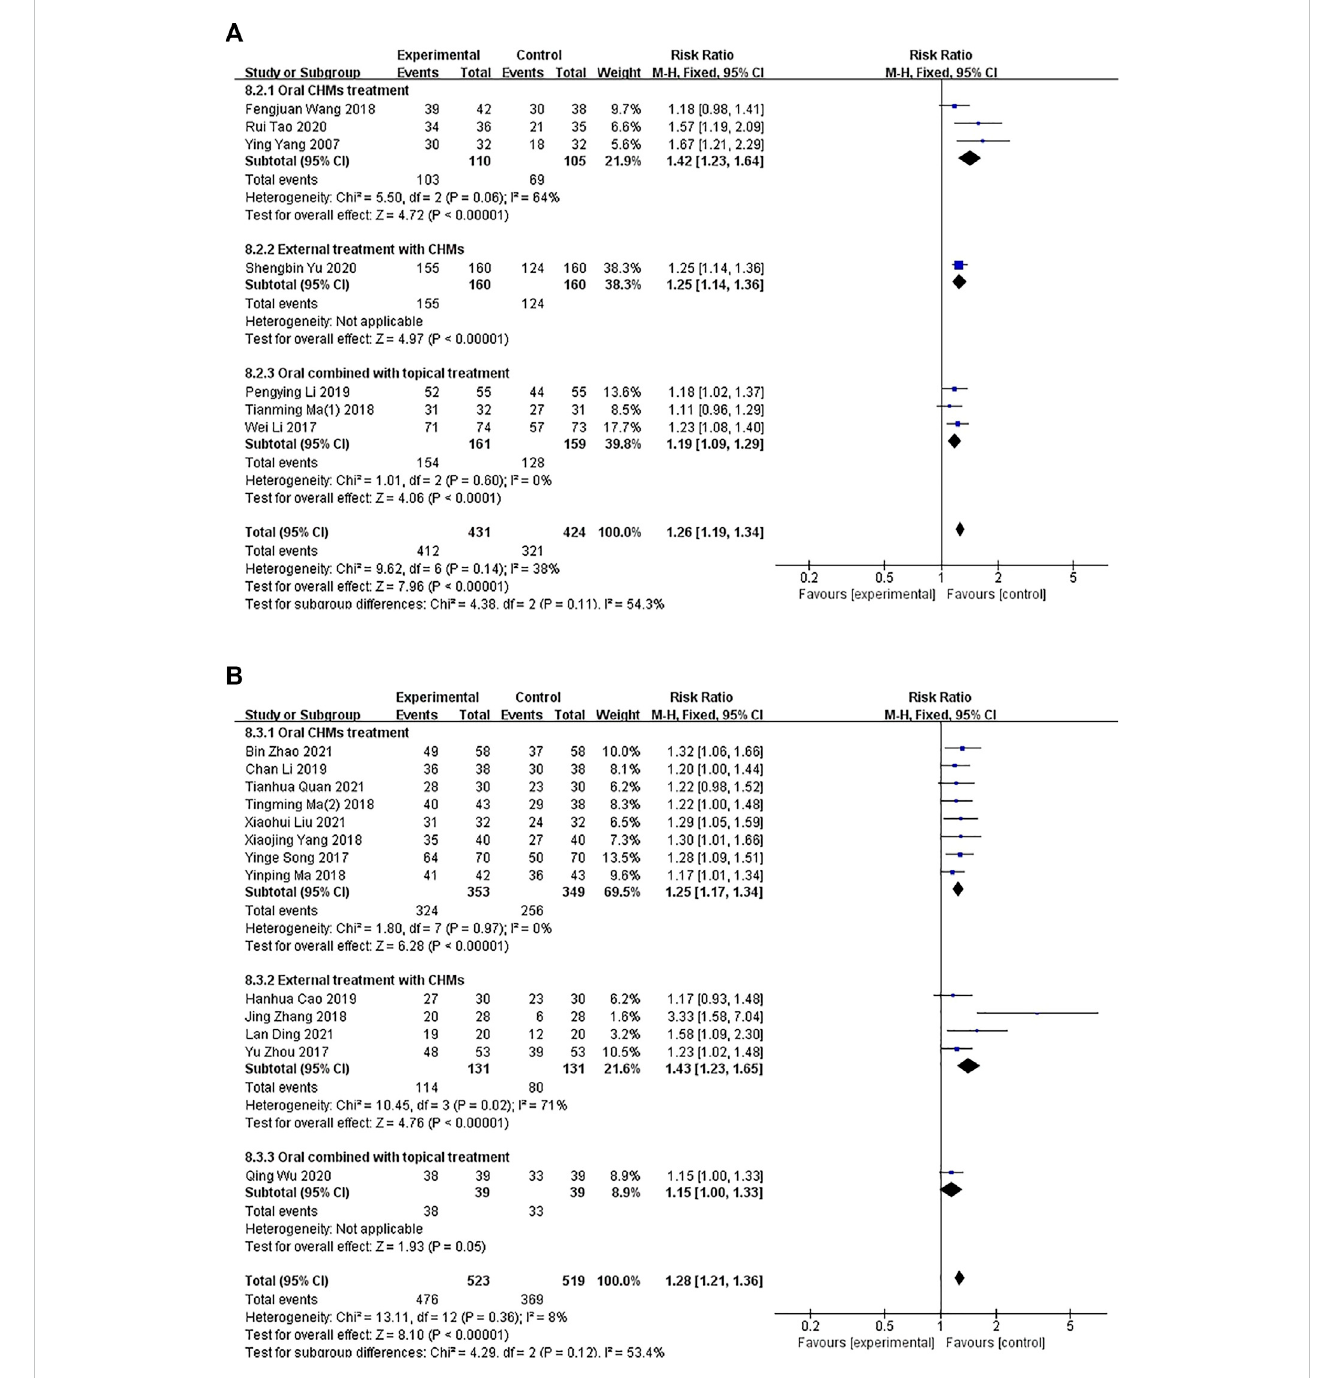
FIGURE 8 Theresultsofthemeta-analysisfortheeffectofChineseherbalmedicine(CHM)oracombinationofCHMandWesternmedicine(WM)versusWMonthe effective rate. (A) CHM versus WM; (B) CHM versus